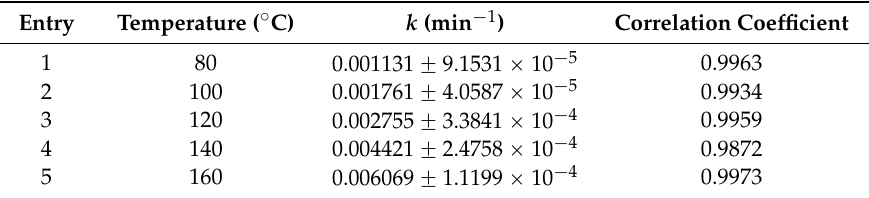
Figure 7. Fructose conversion when increasing the temperature from 80 to 160 °C. Table 3. Rate constants ( k ) of fructose conversion at different reaction temperatures with CePW 12 O 40 as the catalyst.